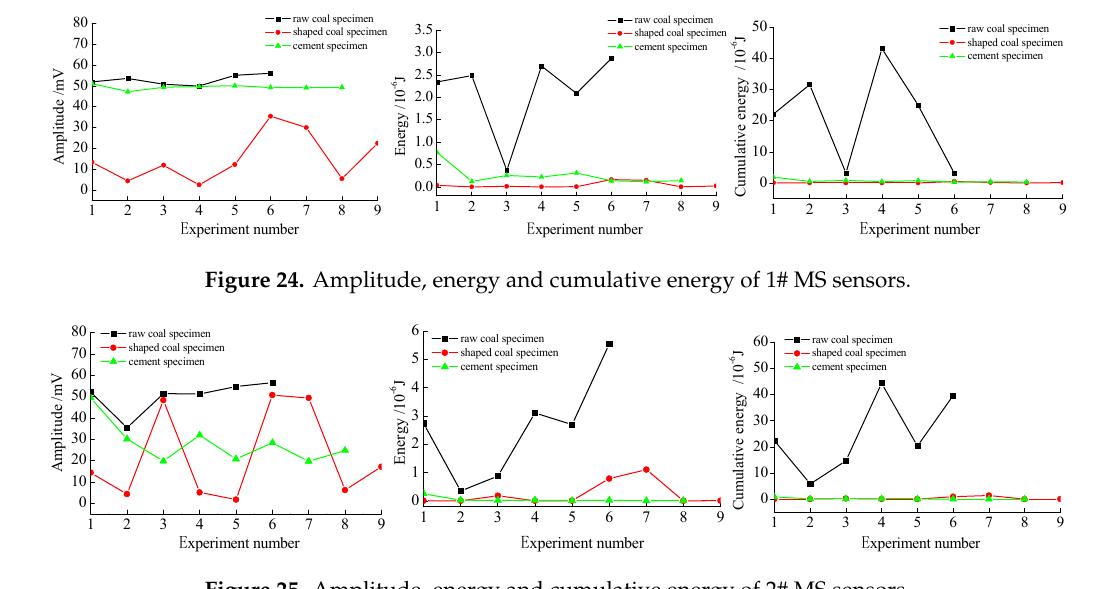
Figure 23. MS and loading force (F) of shaped coal and cement specimens. ( a ) Shaped coal and ( b ) cement.